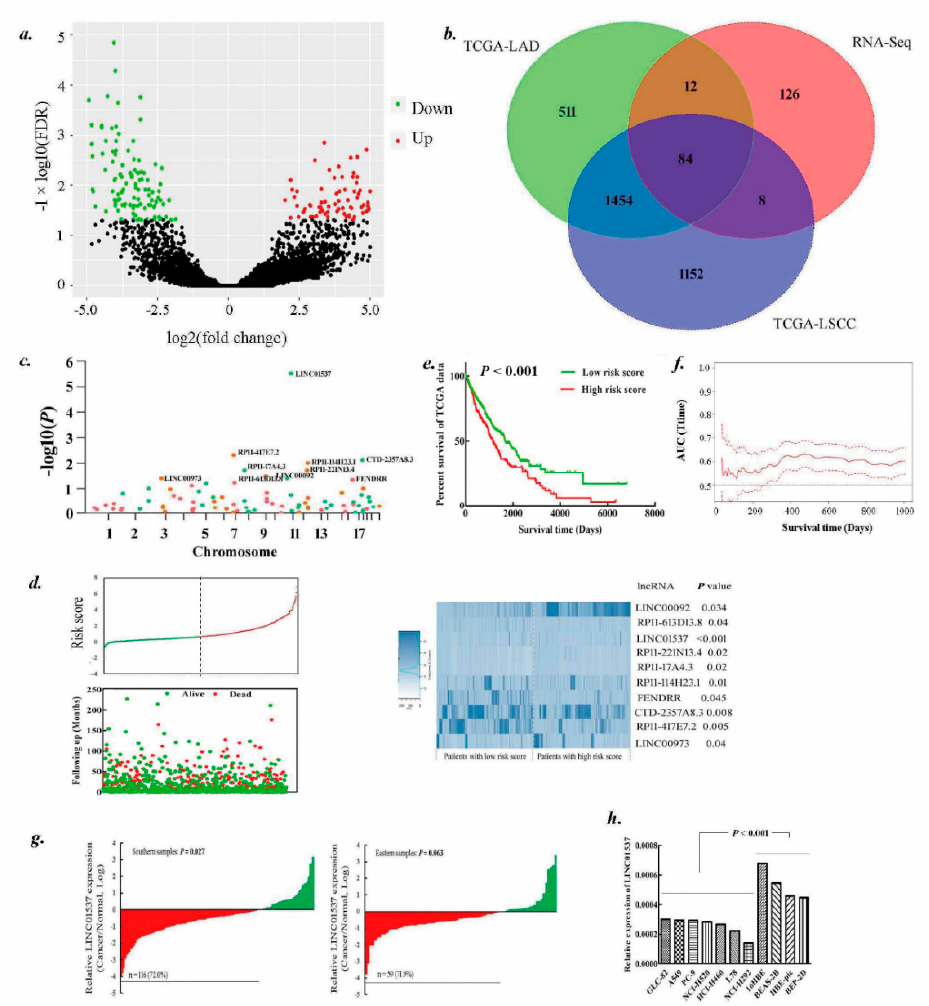
Figure 1. Identification of lung cancer survival-related long non-coding RNAs (lncRNAs). ( a ) . Volcano plot for comparison of lncRNAs expression profiles between eight pairs of lung cancer tissues and adjacent normal lung tissues. The x-axis indicates the differential expression profiles, plotting the fold-change in a log scale; the y-axis indicates the statistical significance of difference in expression. Green color dots represent downregulated lncRNAs and red ones represent upregulated lncRNAs with false discovery rate (FDR) < 0.05. ( b ) . Venn diagram for comparison of differentially expressed lncRNA profiles among RNA sequencing (RNA-seq) data, TCGA LUAD data, and squamous cell carcinoma (LSCC) data. ( c ) . Scatter plot of p values in –log10 scale from the univariate Cox model analysis on 84 lncRNAs that were overlapping in the above-mentioned differential lncRNA expression profiles. Green for downregulated lncRNAs and red for upregulated ones. Ten lncRNAs with significant p values were labeled. ( d ) . The distribution of ten-lncRNA risk score, patients’ survival status, and lncRNA expression. p value from the univariate Cox model. ( e ) . The Kaplan–Meier plot was used to visualize the survival probabilities for the low-risk versus high-risk group of TCGA lung cancer patients determined on the basis of the median risk score. The differences between the two curves were determined by the log-rank test. ( f ) . Prognostic score in the TCGA lung cancer cohort, predicted by the ten-lncRNA risk score in terms of the AUC (Area Under Curve.) of time-dependent receiver operating characteristic (ROC). The full line and dashed lines refer to AUC values and their 95% confidence intervals. ( g ) . The qPCR was performed to assess the expression of LINC01537 in the tissues of southern (left) and eastern (right) groups. p was calculated by the paired t test. ( h ) The qPCR was performed to assess LINC01537 expression in lung cancerous and immortalized normal cells. p was calculated by the Student’s t test.